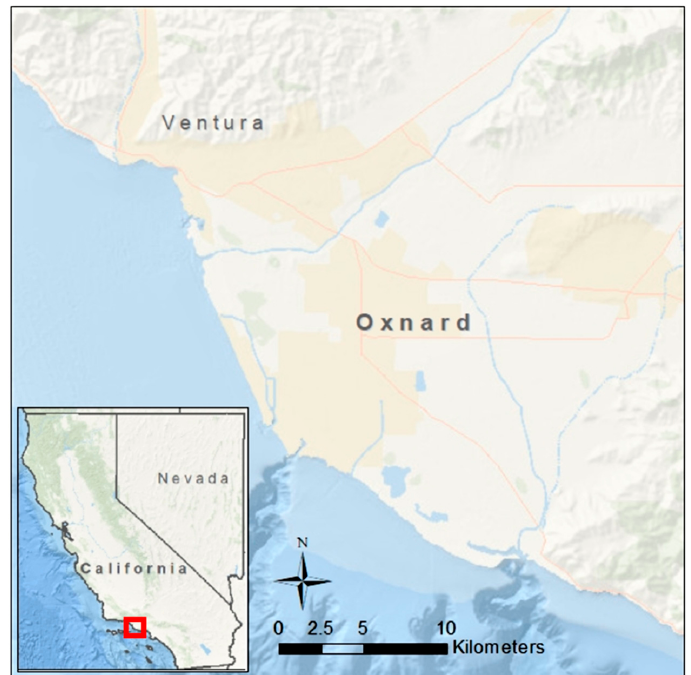
Figure 1. Map of study area: Oxnard, California. The red box indicates the location of Oxnard within California, corresponding with the close up view of Oxnard.